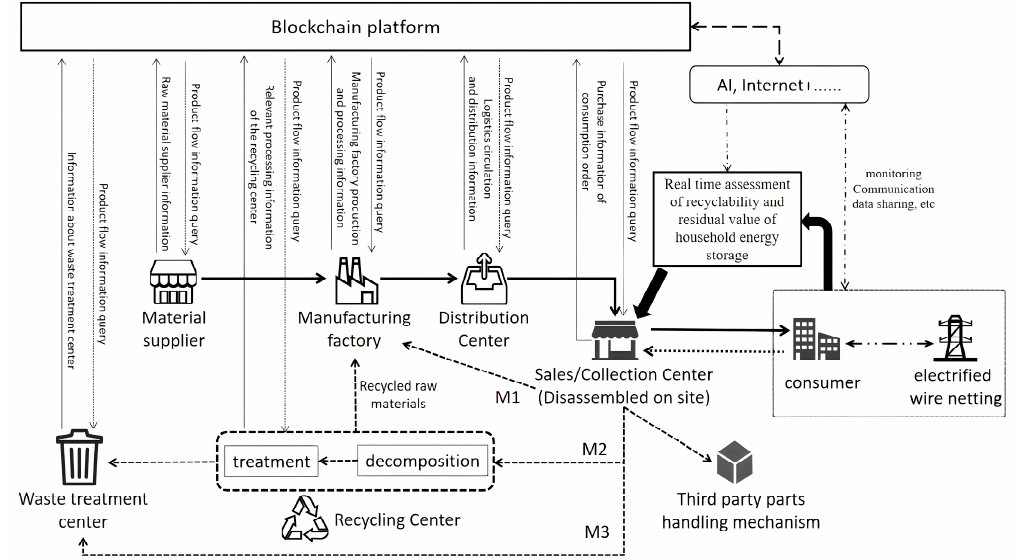
Figure 1. The household energy storage recycling system.